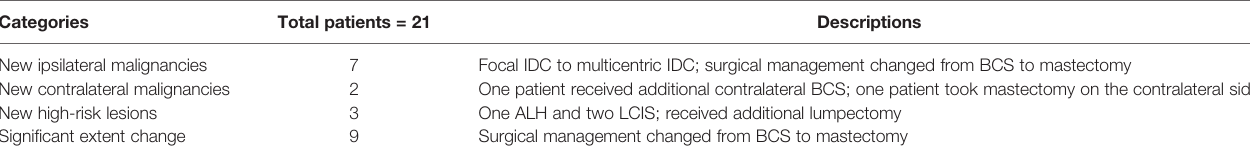
TABLE 3 | Patients with altered surgical management by the second-look US.